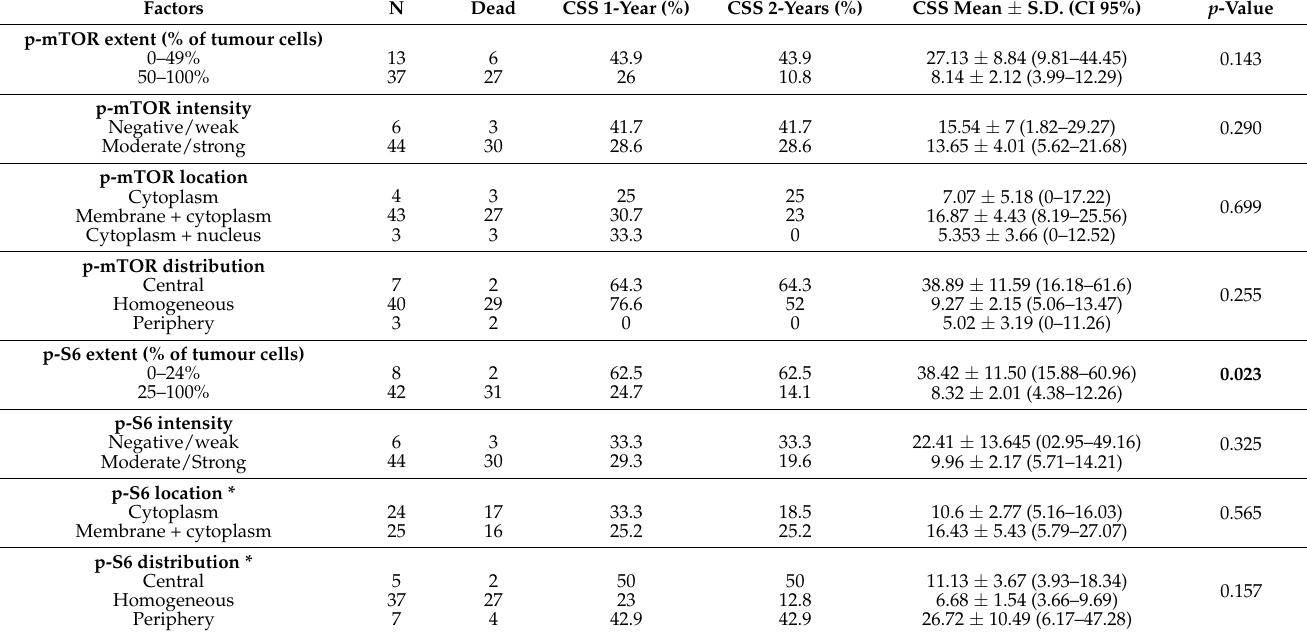
Table 5. Univariate analysis of cancer-specific survival (CSS) according to biomarkers expression.